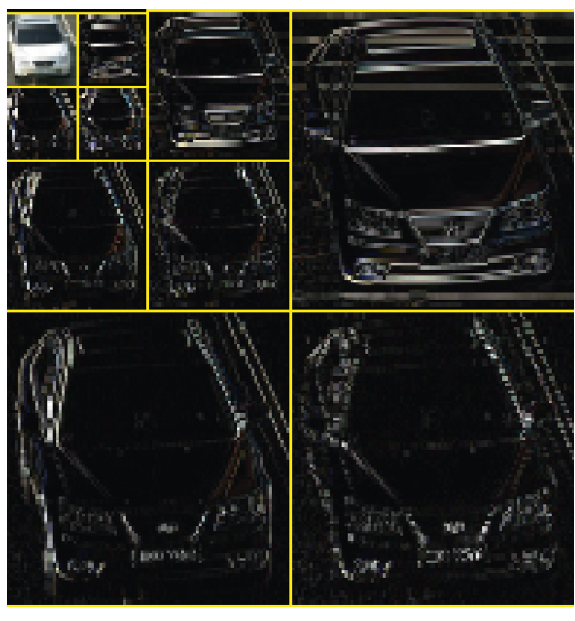
Figure 7: Third level of 2D-DWT.